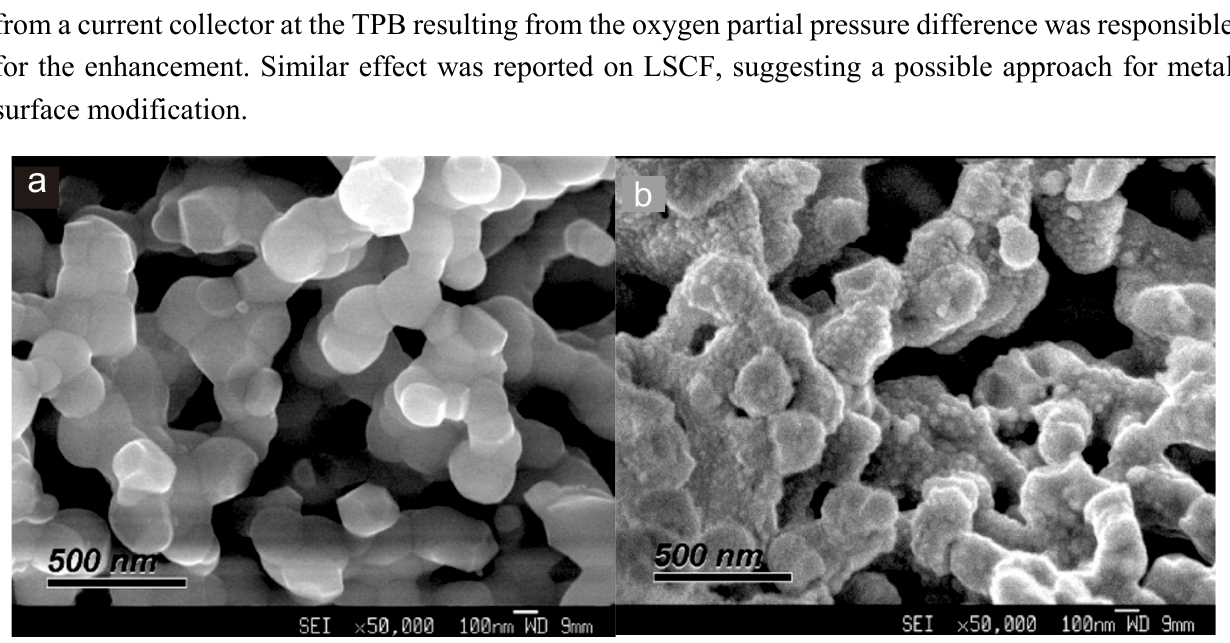
Figure 3. SEM pictures of fractured cross sections of ( a ) pure LSCF; ( b )